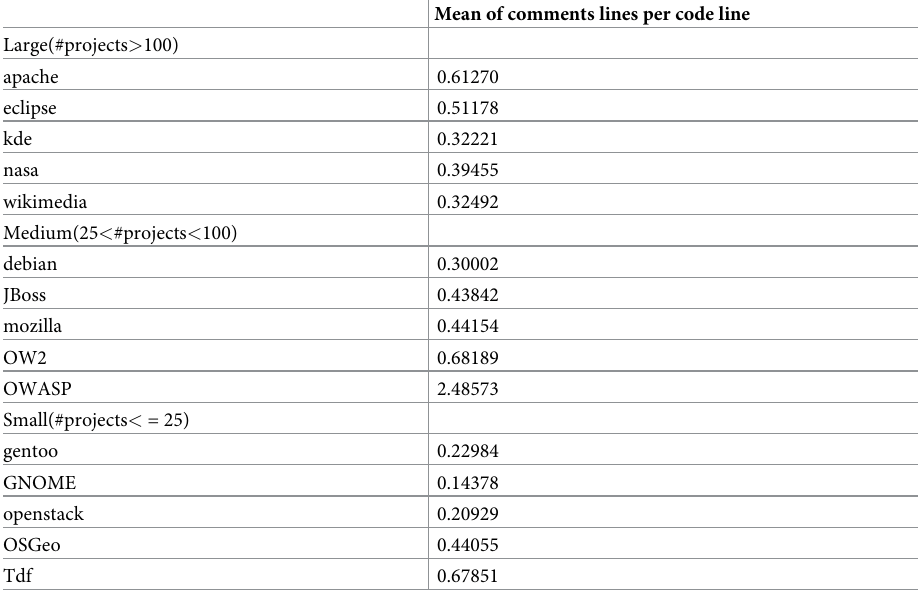
Table 6. Mean COMPCOD